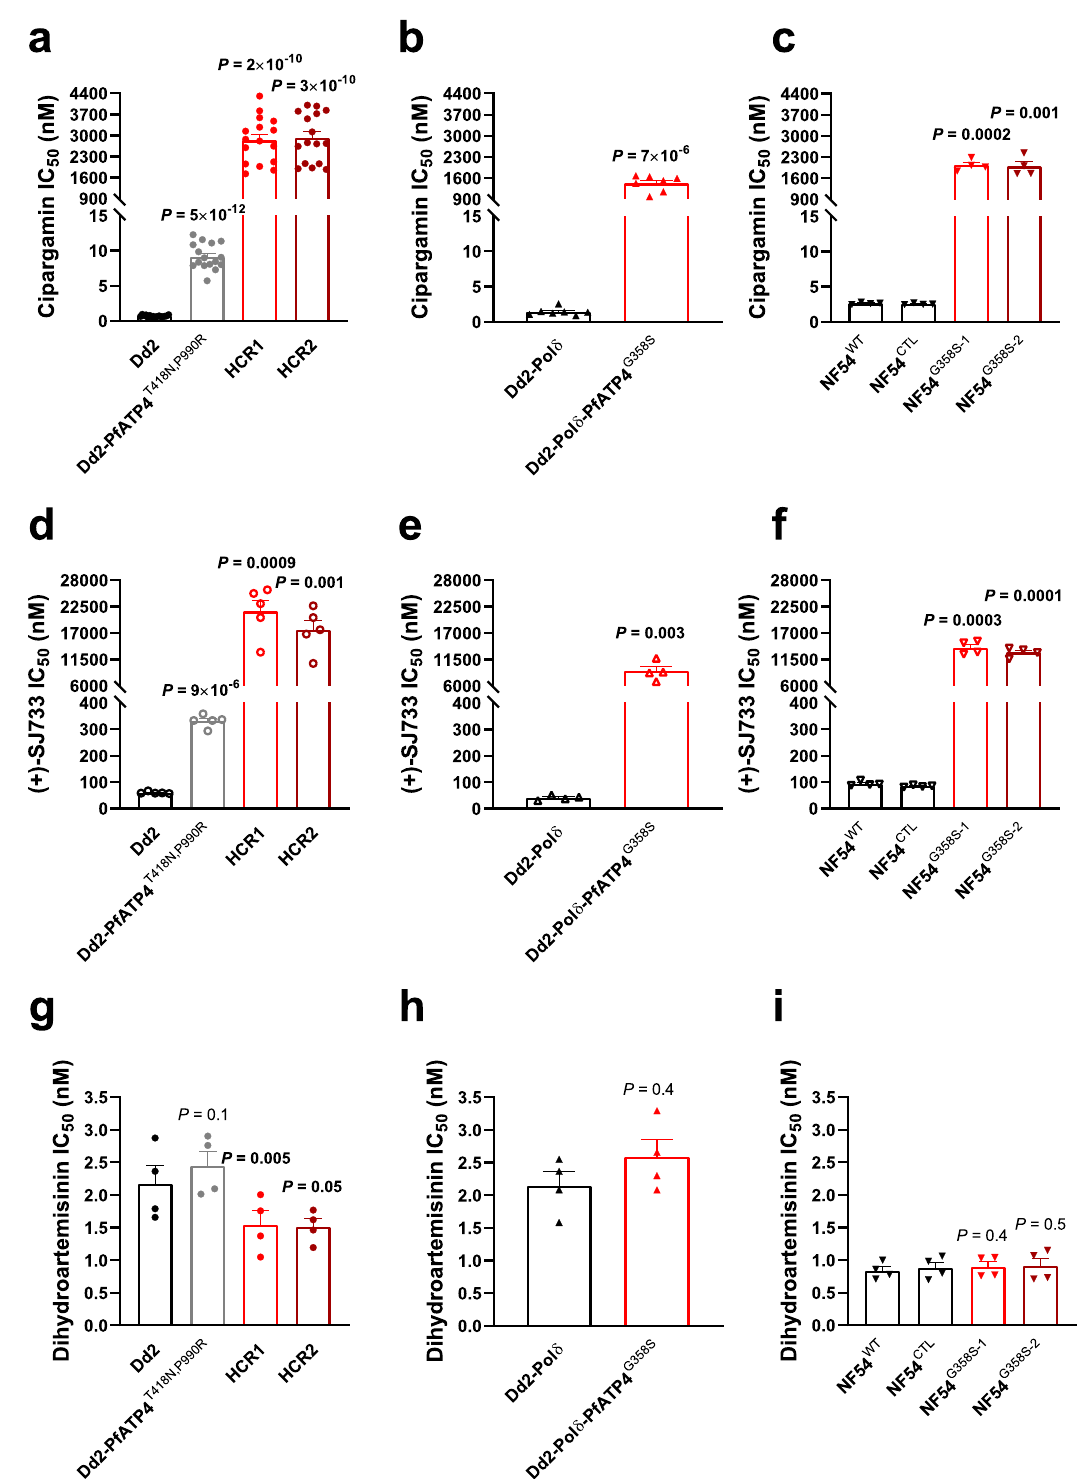
Fig. 2 | Parasites with the G358S mutation in PfATP4 display a high level of resistance to cipargamin and (+)-SJ733. IC 50 values are shown for cipargamin ( a – c ), (+)-SJ733 ( d – f ) and dihydroartemisinin ( g – i ) against HCR parasites (clone #1 in red and clone #2indarkred)generated throughinvitroevolutionwiththe Dd2- PfATP4 T418N,P990R line (grey; with data for its Dd2 parent also shown in black; a , d , g , circles), Dd2-Pol δ -PfATP4 G358S (red) parasites generated through in vitro evolutionwiththeDd2-Pol δ line(black; b , e , h ,triangles),andtwoNF54 G358S lines(1 in red and 2 in dark red) generated using CRISPR-Cas9 with the NF54 WT line (black; along with the matched recombinant control line NF54 CTL in black; ( c , f , i ), upside